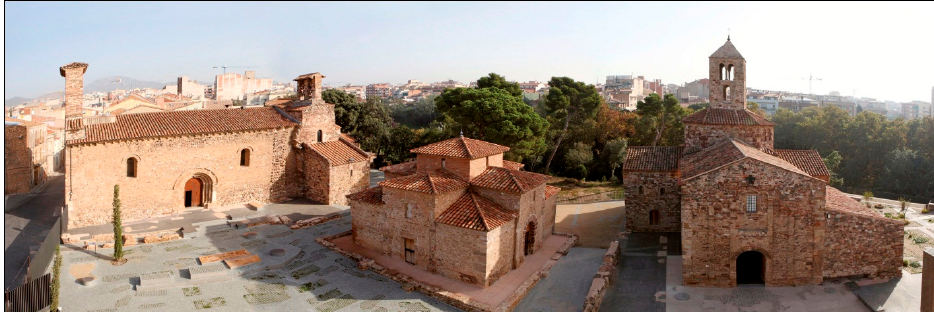
Figure 1. The Ancient Episcopal See of Egara. © Museu de Terrassa (with kind permission).